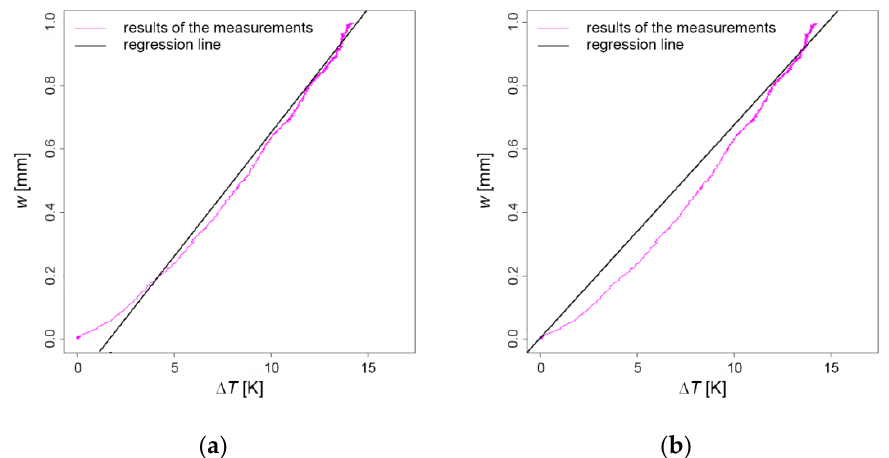
Figure 15. ( a ) The regression line relating the temperature differences and the top deflections; ( b ) The regression line additionally assuming the intercept at zero.